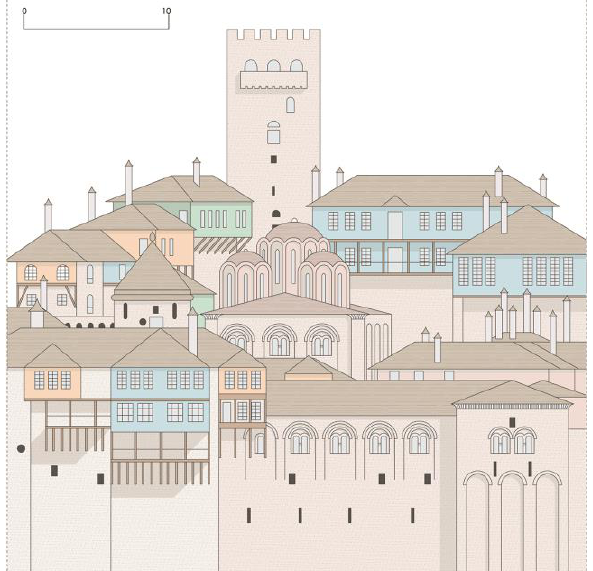
Figure 16 . The Monastery of Dochiariou. Detail of the western